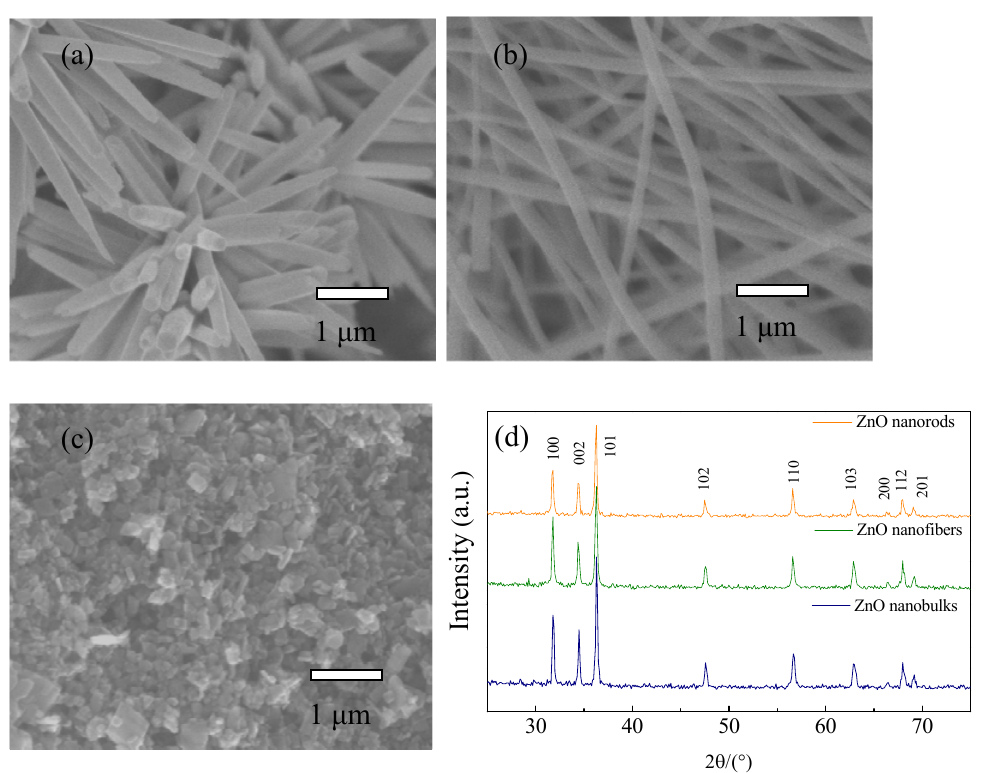
Figure 2. FESEM images of ZnO nanorods ( a ); nanofibers ( b ); nanobulks ( c ) and their XRD patterns ( d